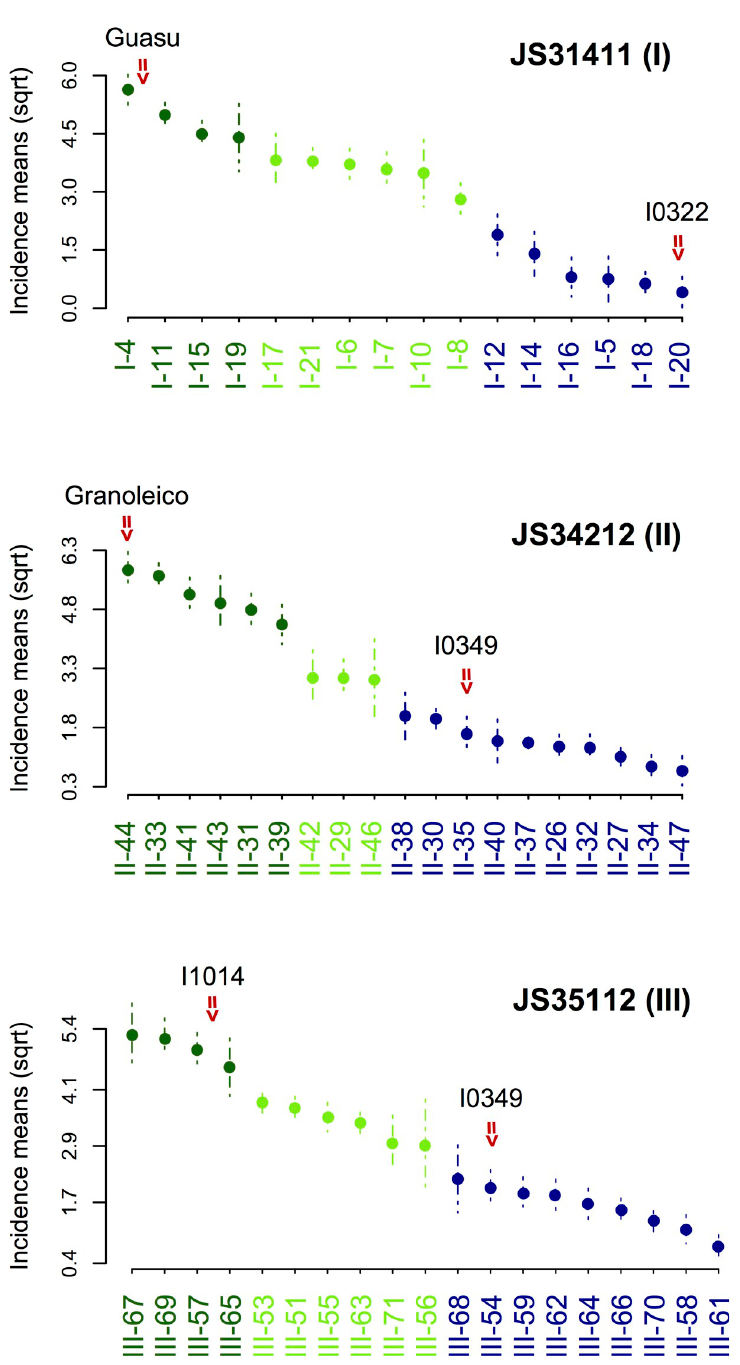
Fig 2. Genotype groups for incidence mean values as defined by the Scott-Knott algorithm ( α = 0.05). Correlation coefficients were calculated both, at the trait and generation levels. At the trait level, a strong correlation ( � 0.80, P � 0.01) was observed between incidence and DI measure- ments for each generation of RIL (Fig 3). At the generation level, correlation coefficients for the same trait in different generations corresponded to the narrow heritability ( h 2 ) of the trait.